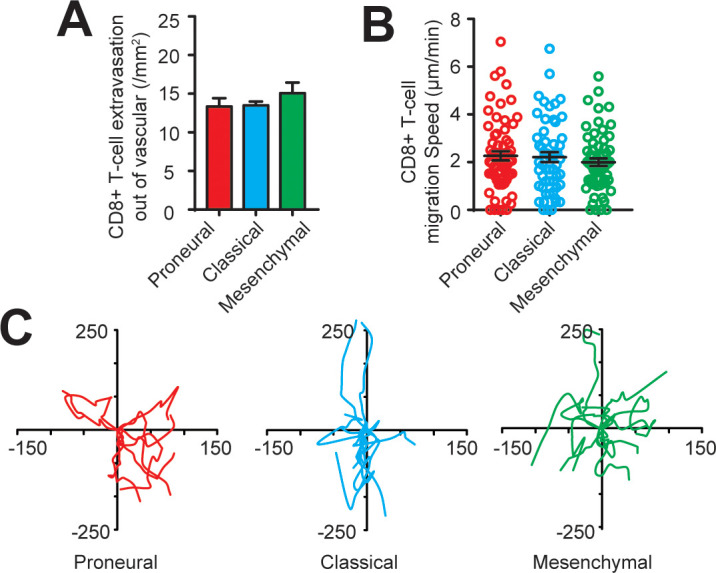
CD8+ T-cell extravasation and infiltration behaviors in the engineered GBM microenvironment without the presence of TAM.(A) Quantified results showing similar amounts of extravasated CD8+ T-cells out of vascular in the PN (GBML20), CL (GBML08) and MES (GBML91) GBMs without the presence of TAM. (B) Quantified results showing the migration speeds of infiltrated CD8+ T-cells in all three GBM subtypes without the presence of TAM are comparable. (C) Representative trajectories of infiltrated CD8+ T-cells in the 2 hr observation window in different GBM subtypes without the presence of TAM. Error bars represent ± s.e.m.